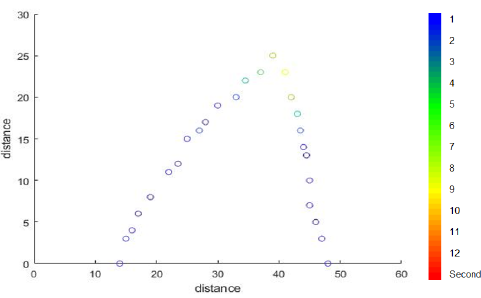
Figure 16. Delay colour